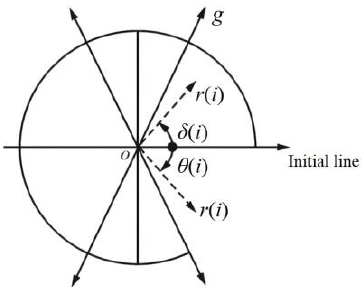
Figure 2. Schematic diagram of symmetrical polar coordinates algorithm.